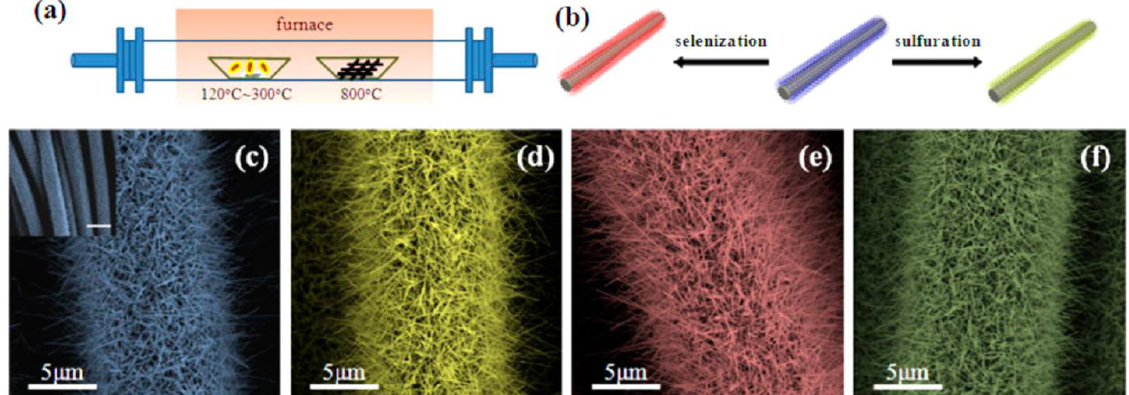
Figure 8. ( a ) Experimental setup of the preparation of WO 3 nanowires and WS 2 , WSe 2 , and WS 2(1 − x) Se 2x nanotubes. ( b ) Schematic diagram of WO 3 nanowires (NWs) converting to WS 2 and WSe 2 nanotubes (NTs) on carbon fibers by sulfidization and selenization. SEM images of ( c ) WO 3 NWs and ( d ) WS 2 , ( e ) WSe 2 , and ( f ) WS 2(1 − x) Se 2x NTs. Reproduced with permission from [39].